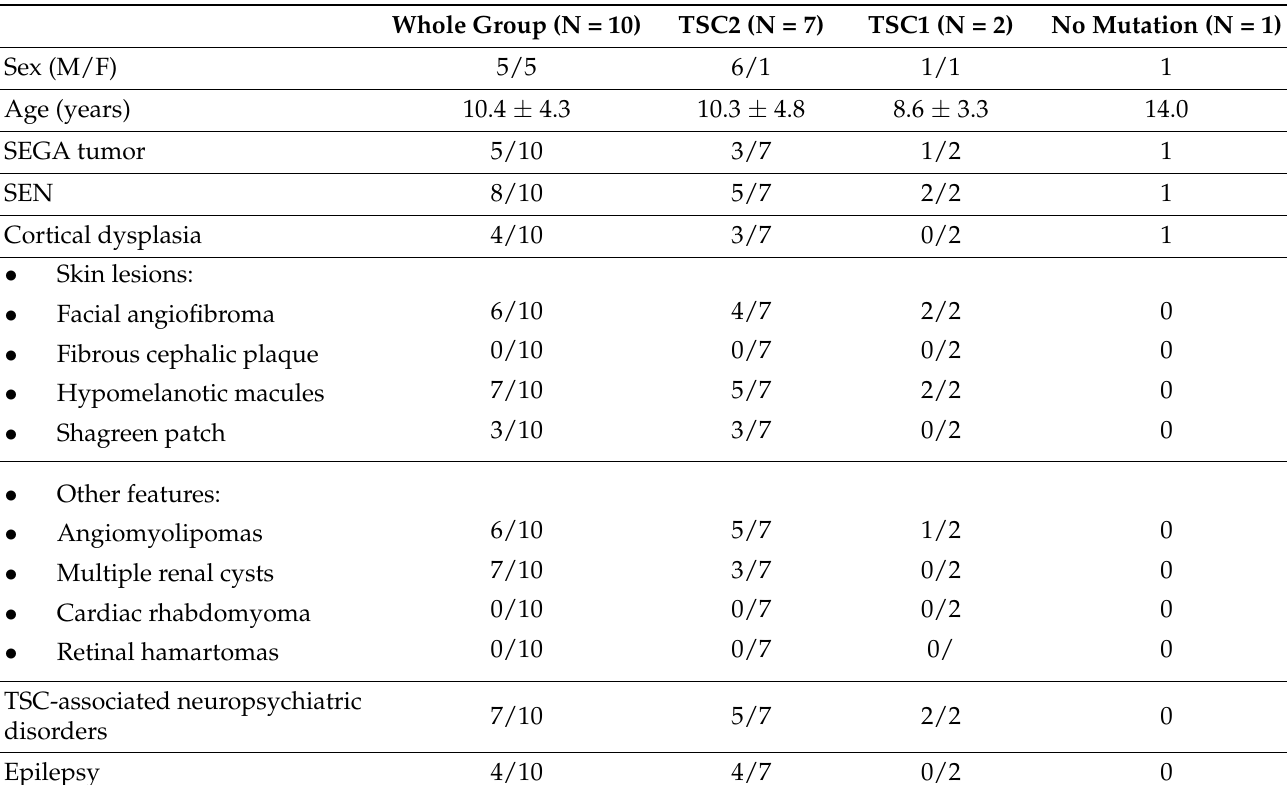
Table 1. Clinical and genetic characteristics of the study group of patients with TSC.